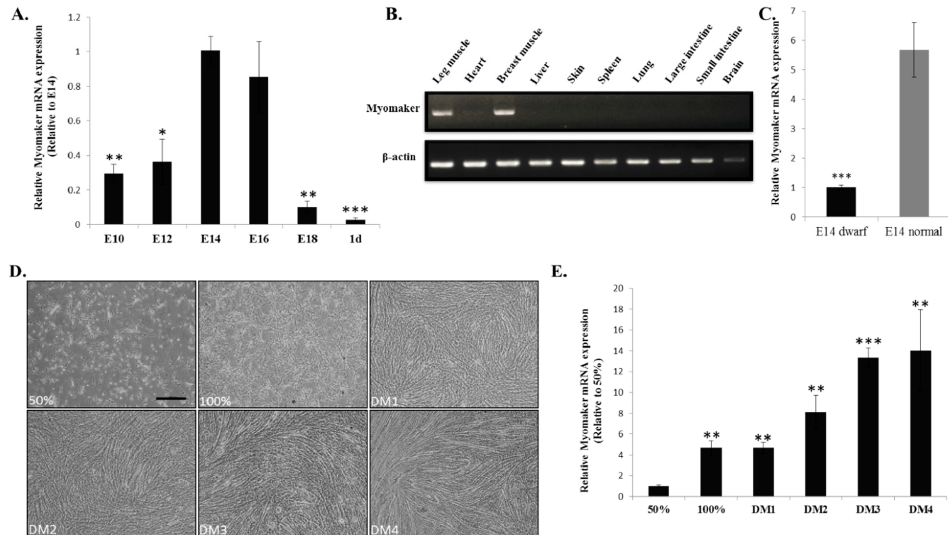
Figure 2. Myomaker mRNA expression during chicken skeletal muscle development. (A) The relative mRNA expression of Myomaker in chicken embryonic leg muscle. β -Actin was used as the reference gene; ( B ) RT-PCR for detecting Myomaker mRNA expression in 10 tissues from E14 chicken. The upper panel shows the bands of Myomaker mRNA; the lower panel shows the bands of β -actin mRNA, which was used as the reference gene. All cropped gels have been run under the same experimental conditions; ( C ) The relative mRNA expression of Myomaker between E14 leg muscles of dwarf chickens and normal chickens; ( D ) Phase-contrast micrographs of proliferating (GM, 50% and 100% confluency) and differentiating (DM) chicken primary myoblasts. Bar, 50 µ m; ( E ) The relative mRNA expression of Myomaker during chicken primary myoblast differentiation. The data in A and C are mean ˘ S.E.M. with six chickens per group. The data in E are mean ˘ S.E.M. with four cultures per group. One-sample t test was used to assess the change from each data point to the control (E14 in A and 50% in E). * p < 0.05; ** p < 0.01; *** p <